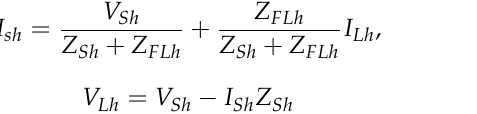
Z , Z and Z , respectively, Sh Lh Fh